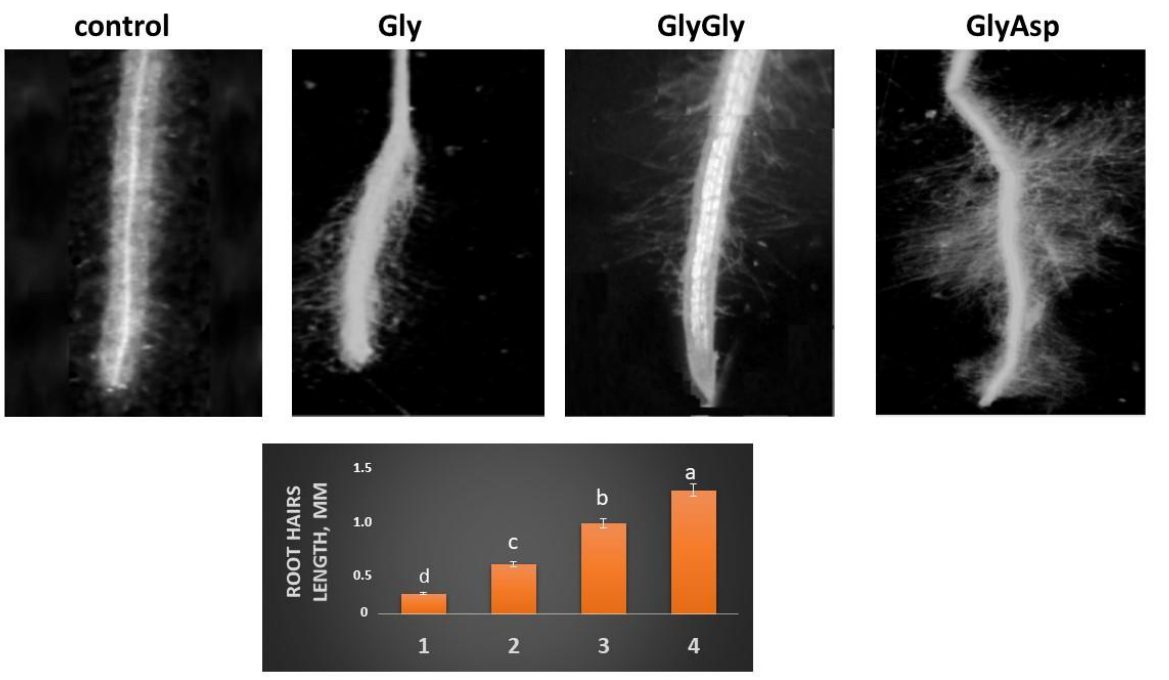
Figure 3. Effect of peptides on the length, density, and pubescence of root hairs of tobacco seedlings. 1—control; 2—Gly; 3—GlyGly; 4—GlyAsp. Scale = 1000 µ m. The mean values ( n = 20) and their standard deviations are shown according to significant value, p < 0.05. Different letters above the bars indicate significantly different values.